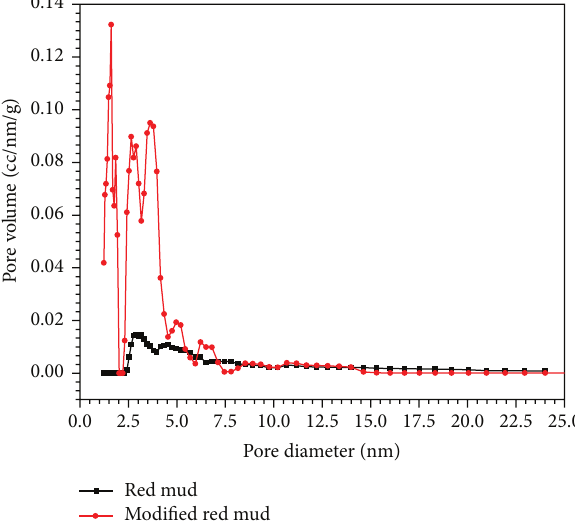
Figure3:Isothermlinearplotofmodifiedredmud(A)andredmud (B). Figure 4: Pore diameter distribution curves of red mud and modified red